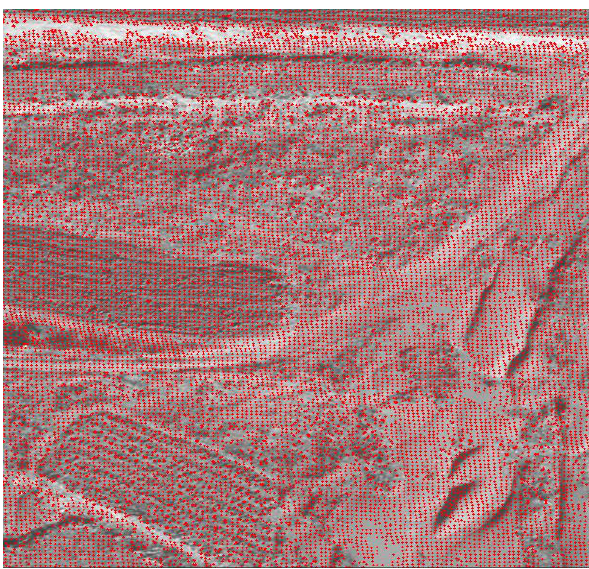
Figure 3. Accuracy-supported dense matching